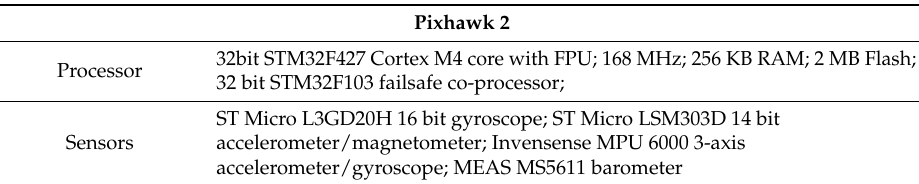
Figure 9. Setup of the aircraft equipment for the experiment. Table 3. “Pixhawk 2” autopilot technical specification.